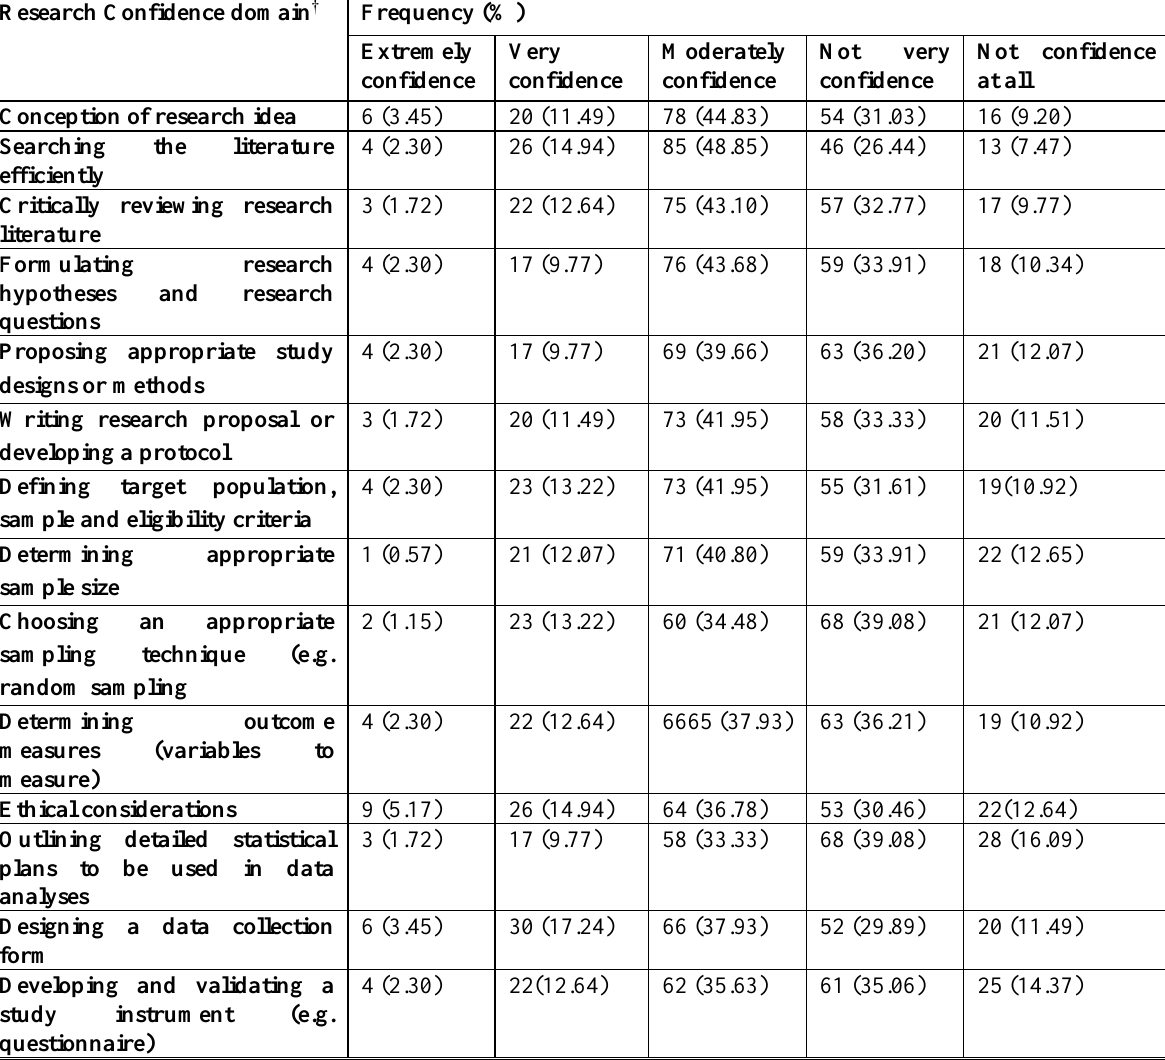
Table 4 Self-perceived confidence of hospital pharmacists in planning and conducting research (n=